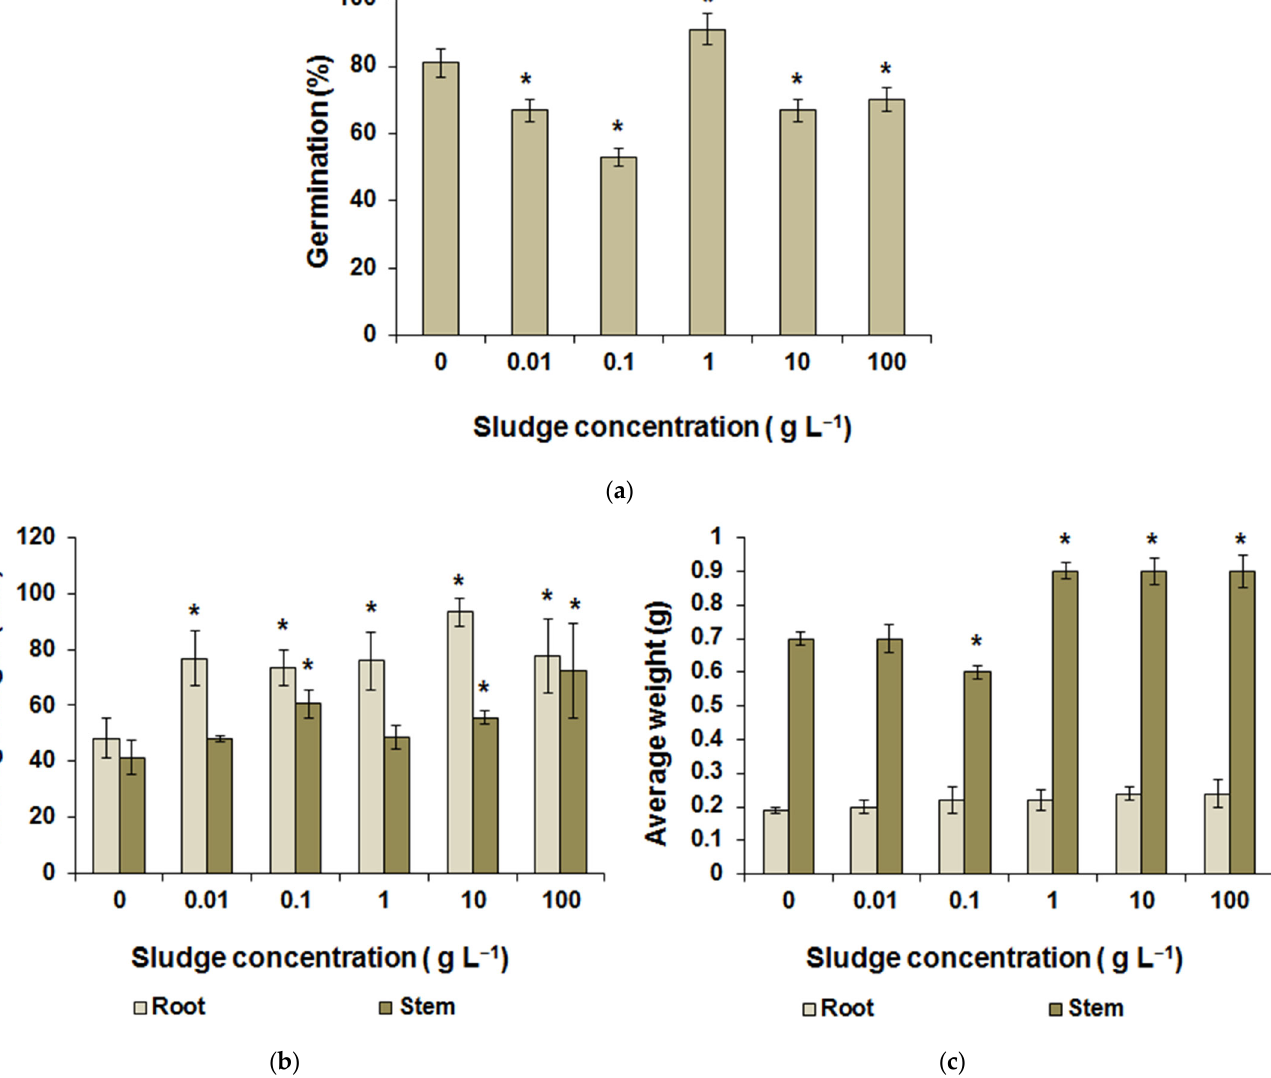
Figure 6. Influence of sludge on rapeseed in a laboratory experiment: ( a ) germination rates; ( b ) morphometric indicators; ( c ) biomass growth. n = 150. *—significant differences with the control.